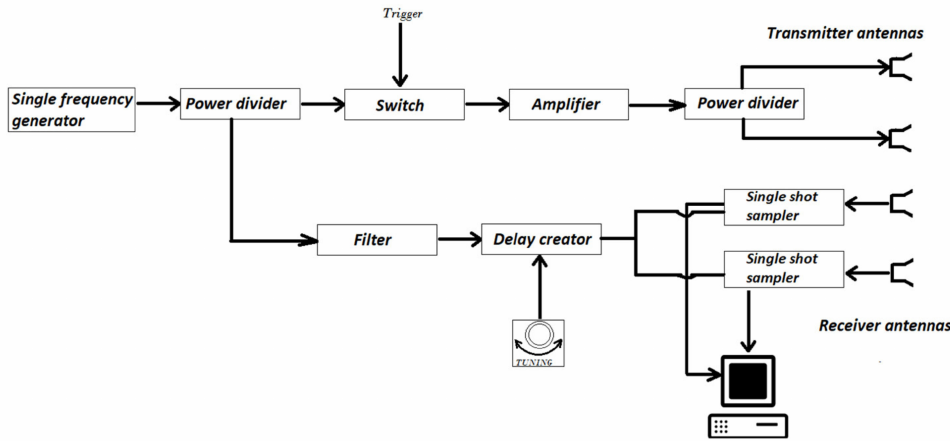
Figure 2. Block diagram explaining different modules of the TRM